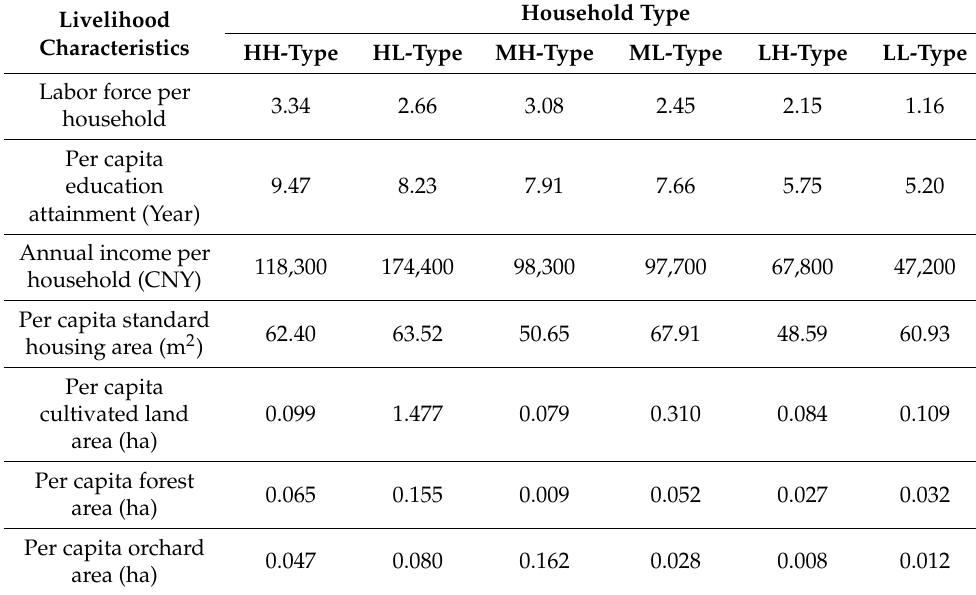
Figure 7. Ratio of the different household type livelihood strategies in the study area. Table 5. Primary household livelihood